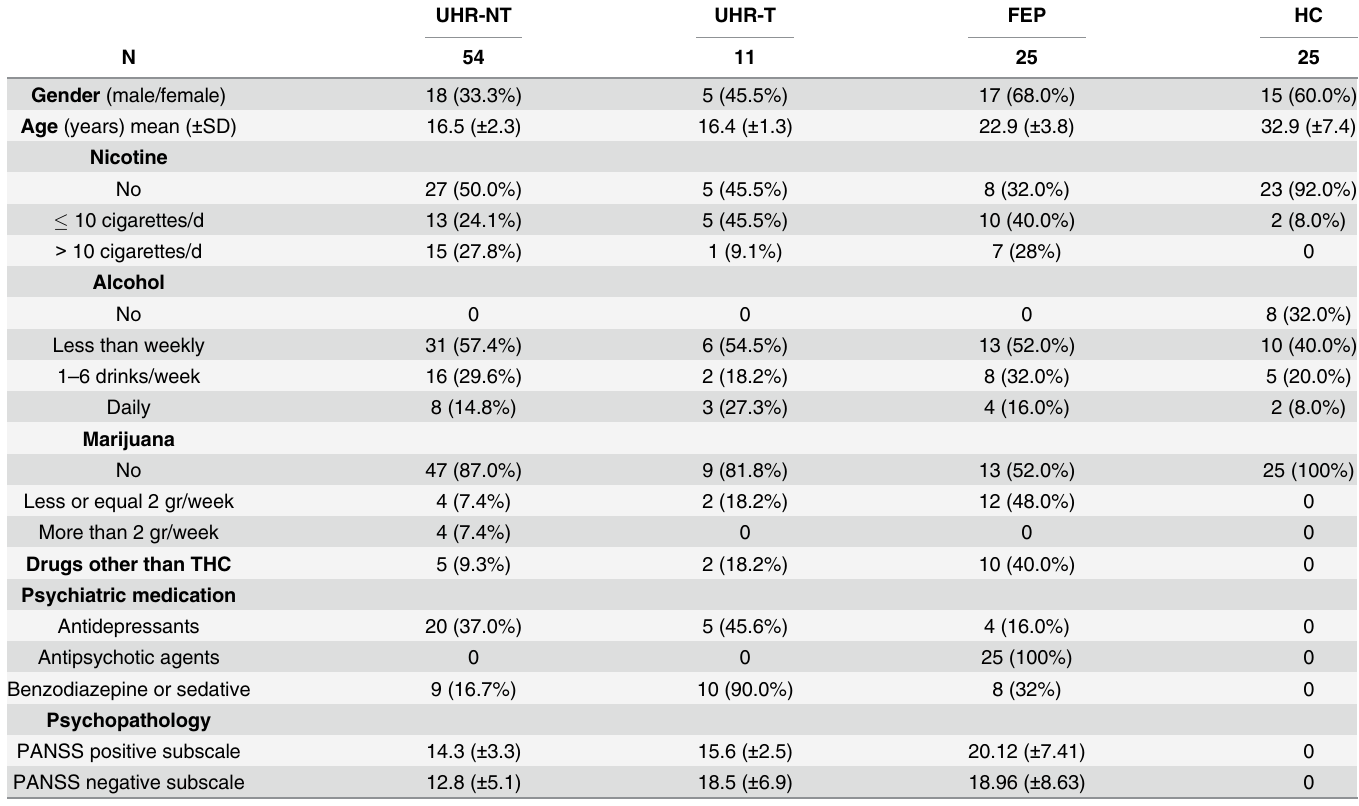
Table 1. Demographic and clinical characteristics of study